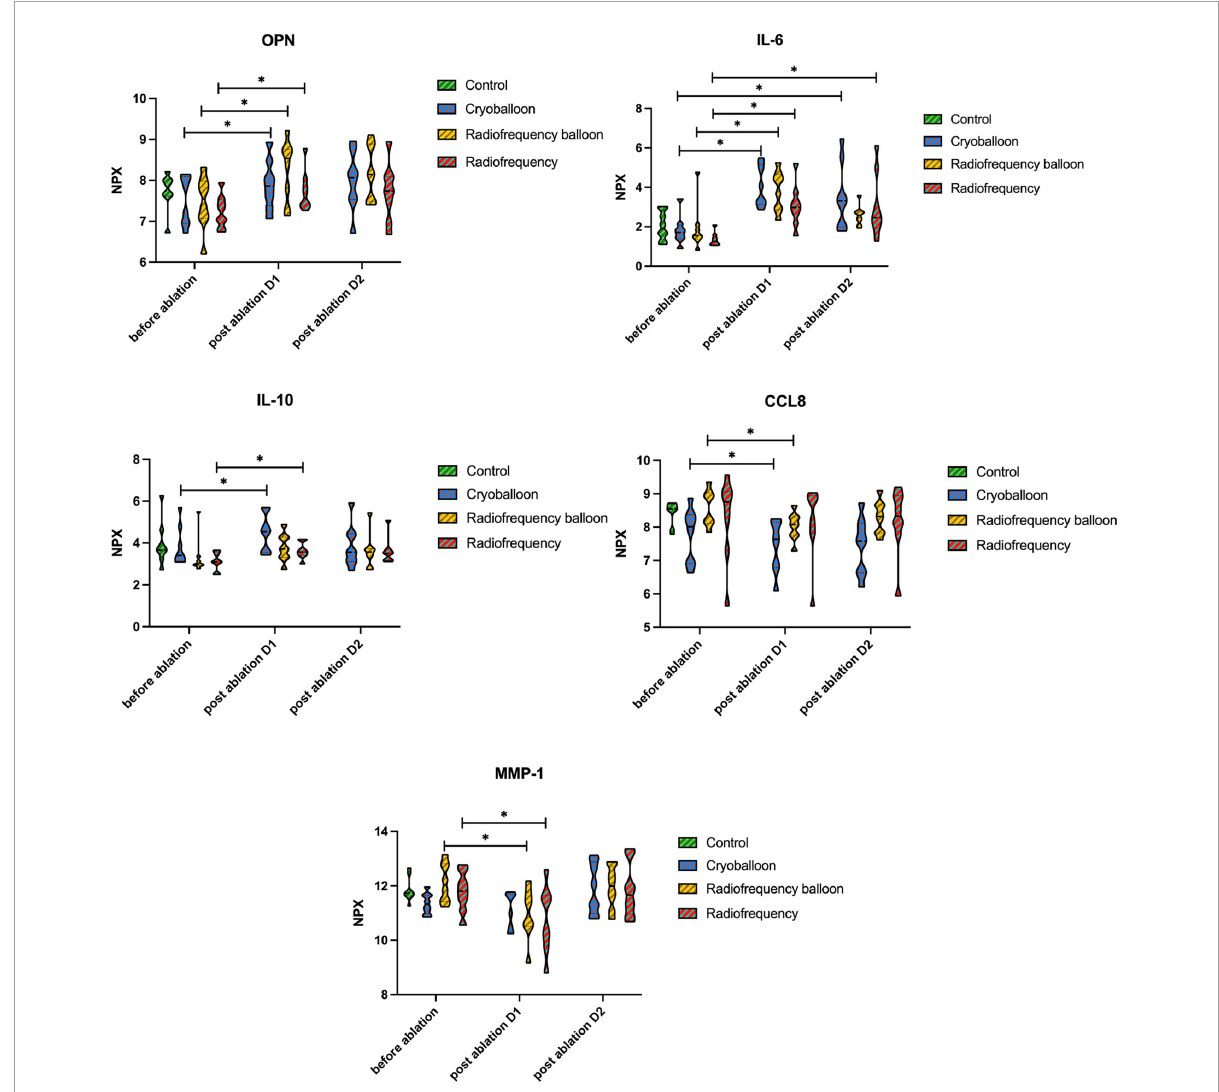
FIGURE5 Levels of seed proteins before and after ablation. No differences were seen between the groups at any time point. Differences before and after ablation were assessed with the Wilcoxon signed-rank test. P -values are given for comparison within the group between different time points. OPN, osteopontin, seed-increased protein in the CB group; IL-6, interleukin-6, seed-increased protein in the RB group; IL-10, interleukin-10, seed-increased protein in the RF group; CCL8, C-C motif ligand 8, seed decreased protein in CB and RB groups; MMP-1, matrix metalloproteinase-1, seed decreased protein in the RF group. NPX, normalized protein expression. ∗ P < 0.05.